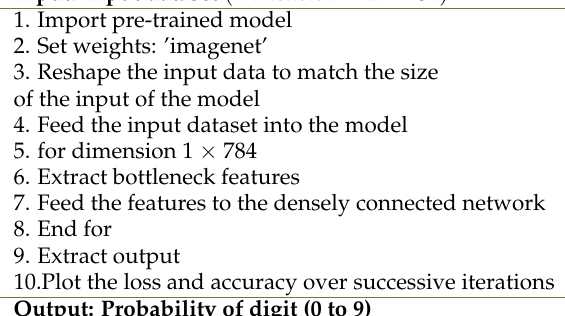
Table 1. Algorithm: Transfer learning for digit